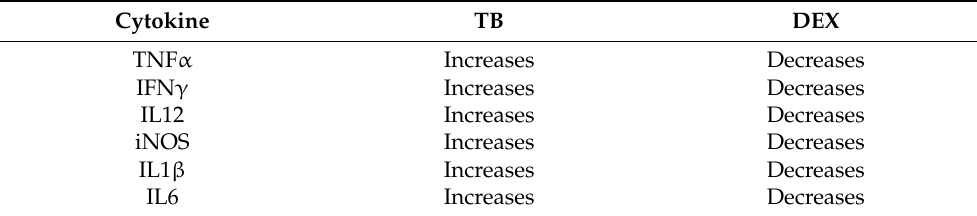
Table 1. More representative cytokines affected by TB and the effect of DEX treatment 1 . Cytokine TB DEX TNF α Increases Decreases IFN γ Increases Decreases IL12 Increases Decreases iNOS Increases Decreases IL1 β Increases Decreases IL6 Increases